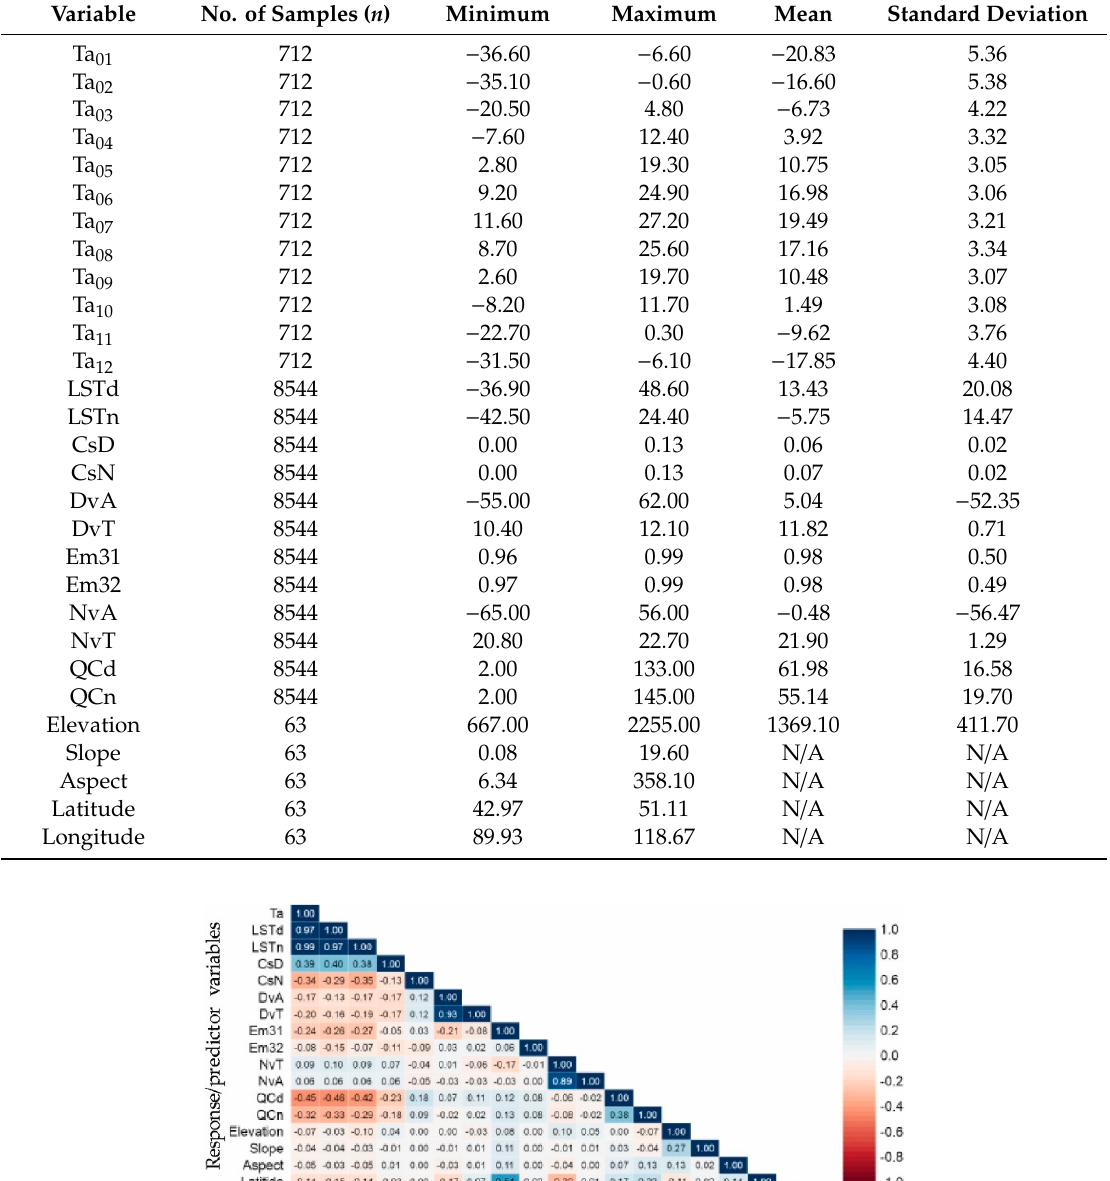
Table 2. List of response/predictor variables and corresponding descriptive statistics (period 2002 to 2017). The list includes the measured air temperature (Ta) reference data at the weather station level ( n = 712 for each of the twelve months) as well as the corresponding seventeen predictor variables extracted from satellite and other geo-data. For the acronyms of the variables, see Table 1. Variable